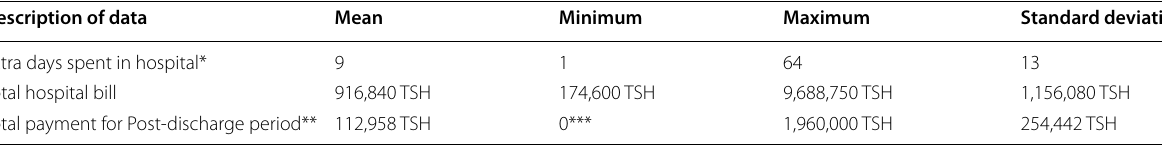
* Represents the number of days spent in the hospital by D-Still patients following medical clearance for discharge ** These payments include coverage of hospital bed and food fees, medications administered daily, changing of dressings, and other elements of patient care allotted to all patients staying in the ward ***Patients who paid 0 TSH for this period were those that absconded from the ward without making any